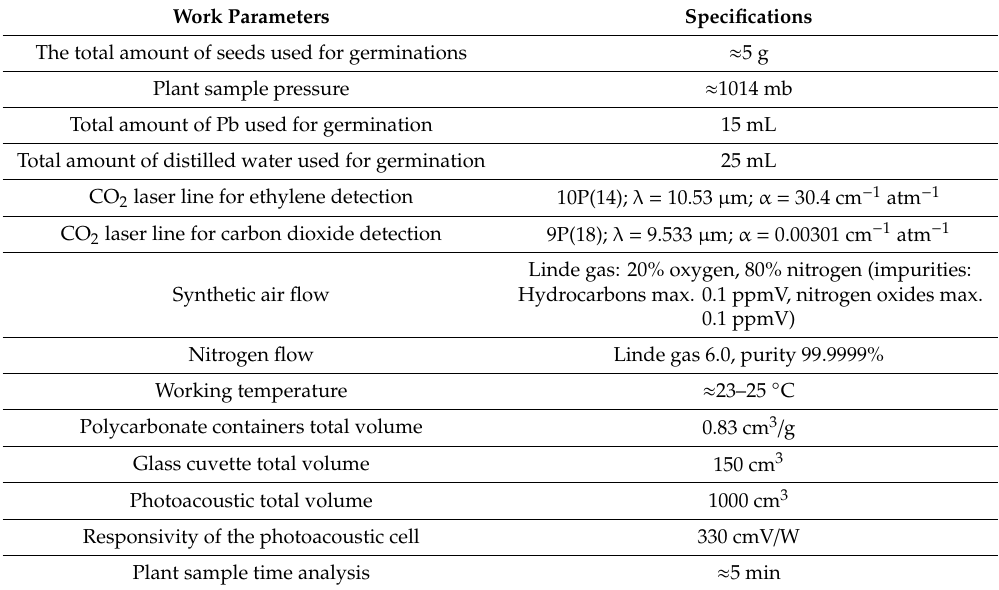
Table 1. Set-up parameters used for ethylene and carbon dioxide molecules